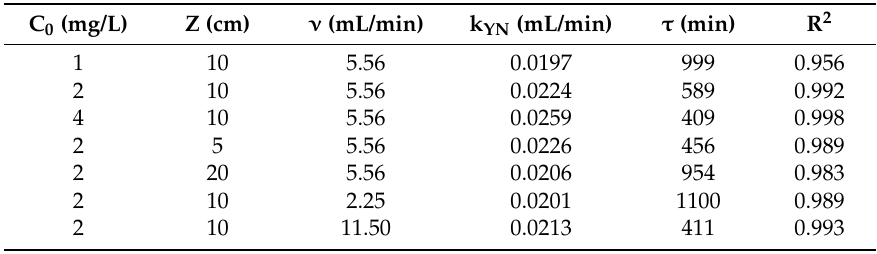
Table 7. Yoon–Nelson parameters for the adsorption of EE2 on PMPS